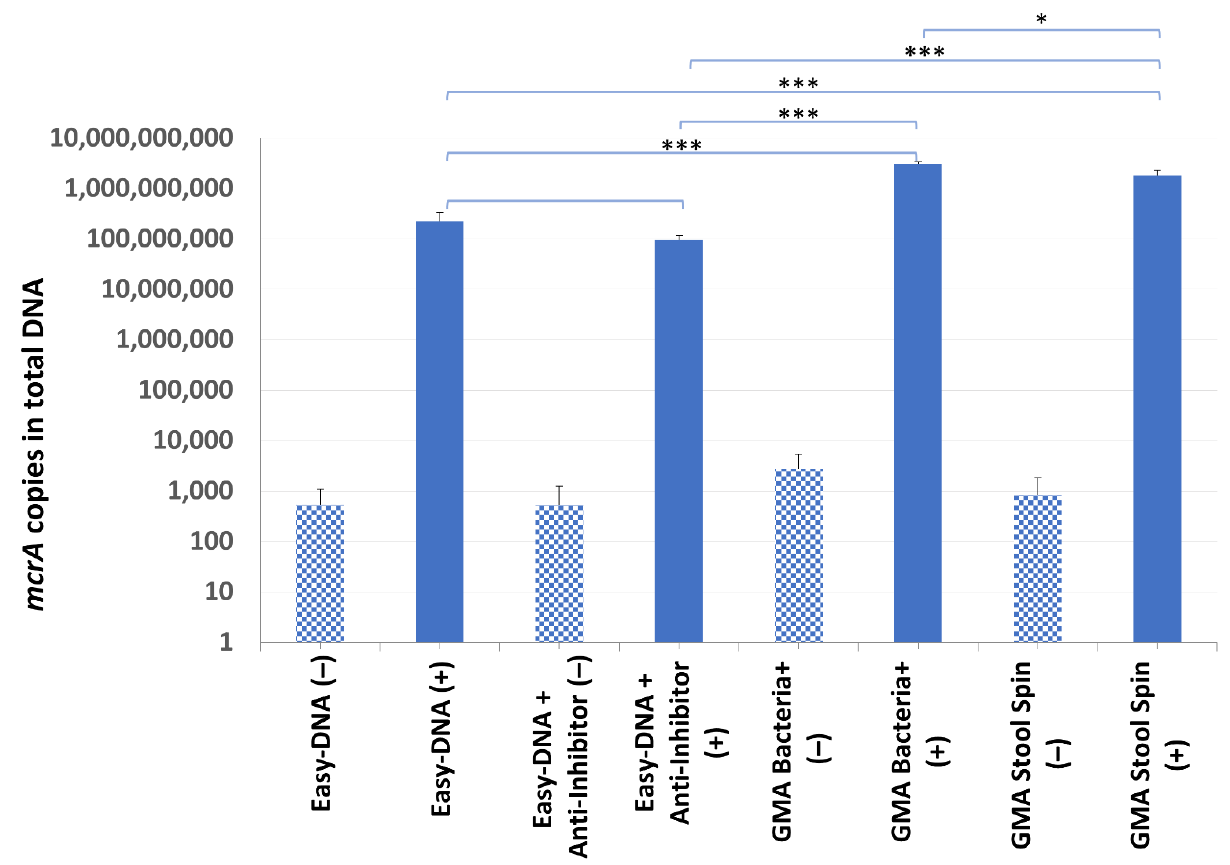
Figure 5. The mcrA quantification results in sample B7. Statistical significance between samples with IC (+) isolated with the use of different kits is marked by asterisks. Patterned bars ( − ) represent archaeal DNA released as a result of a single freeze–thaw cycle. Values of * p < 0.05, and *** p < 0.001 were regarded as significant. NS; not-significant.